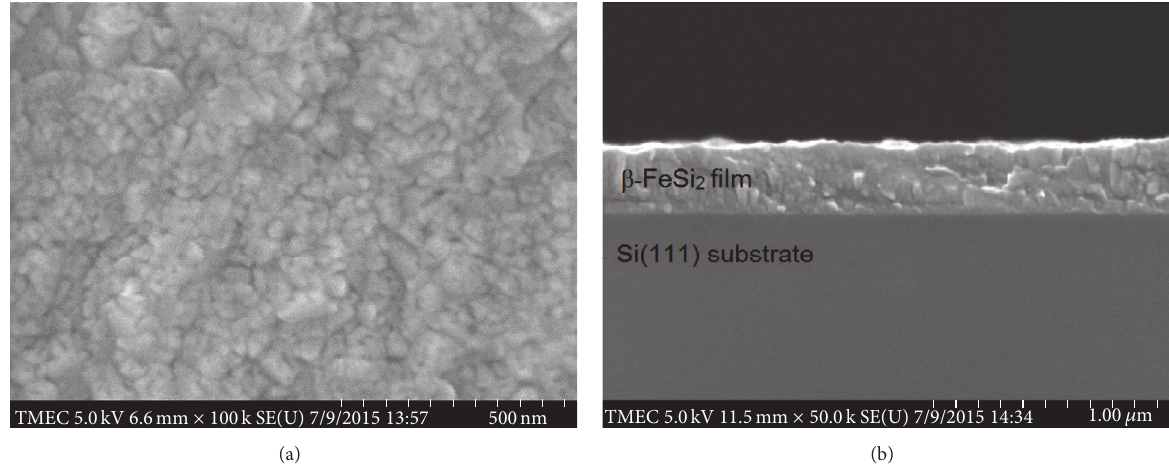
Figure 2: (a) SEM micrograph of the surface for 𝛽 -FeSi 2 thin films grown by RFMS on Si(111) substrates and (b) a cross-sectional SEM micrograph of the 𝛽 -FeSi 2 thin films on Si(111)